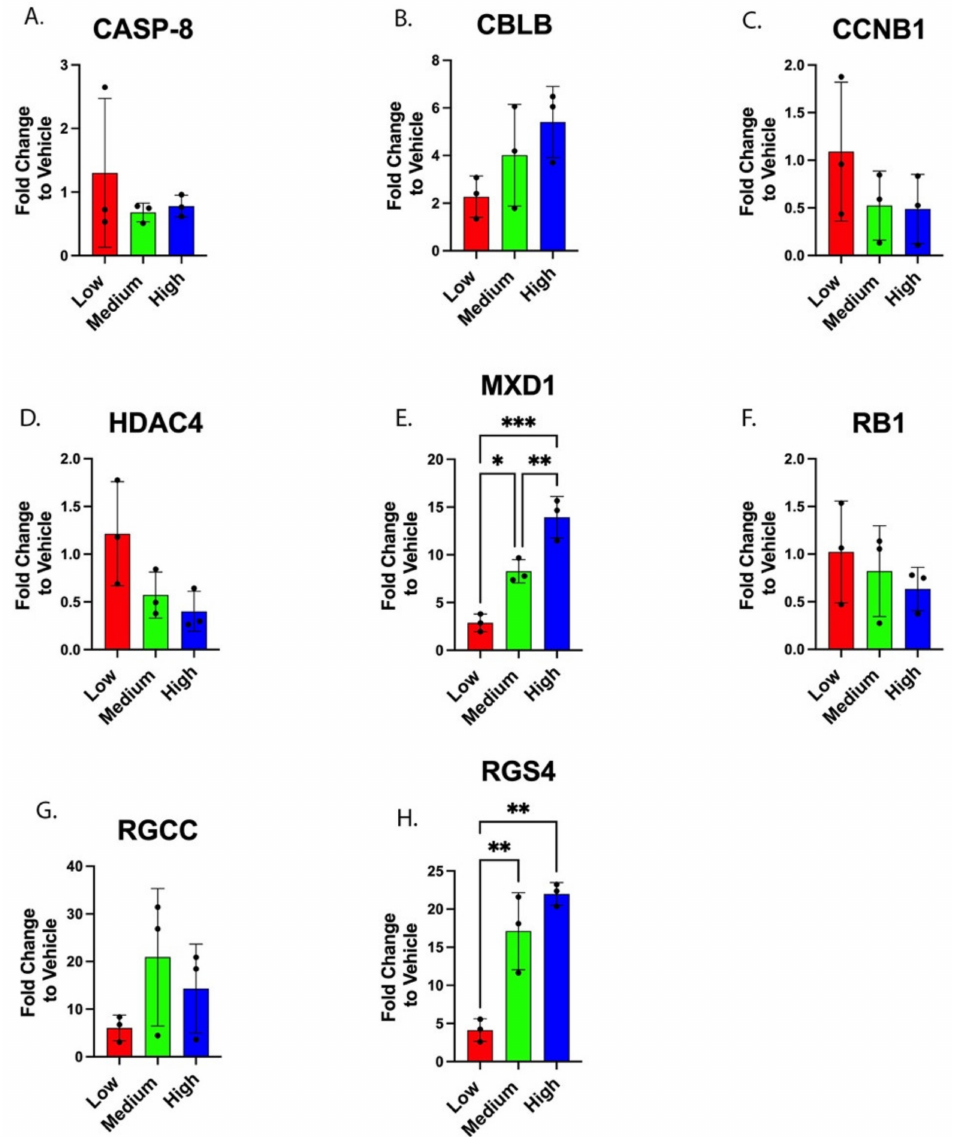
RB1 ) lacked significance in the changes in gene expression levels between Poly E treatment groups, and had mean values of gene expression fold-changes of <2-fold.